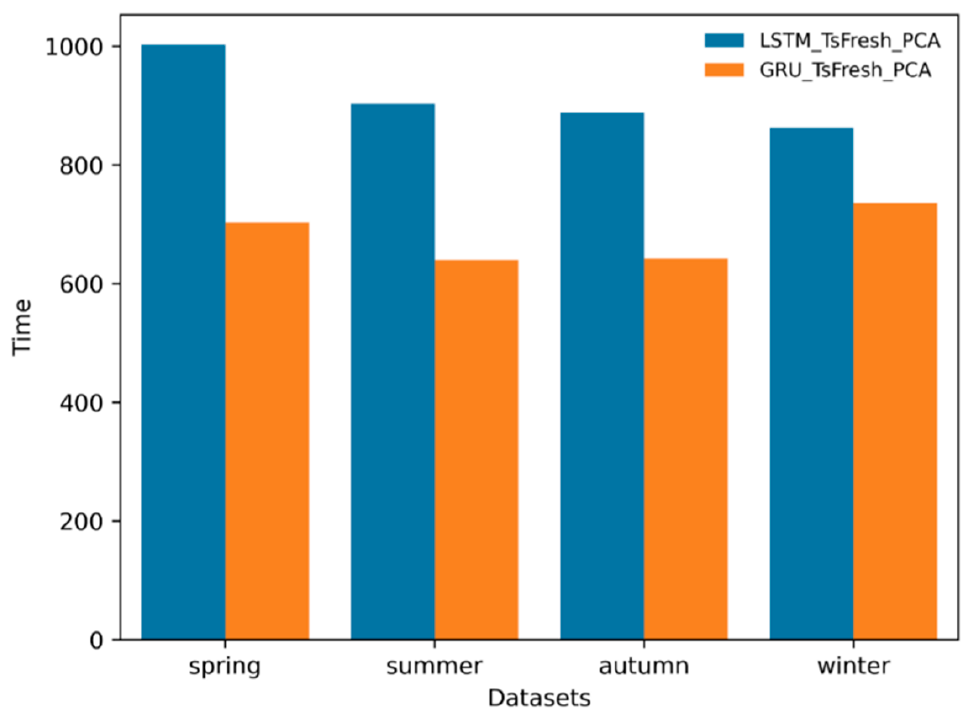
Figure 13. Comparison of prediction time of LSTM_Tsfresh_PCA model and GRU_Tsfresh_PCA model.